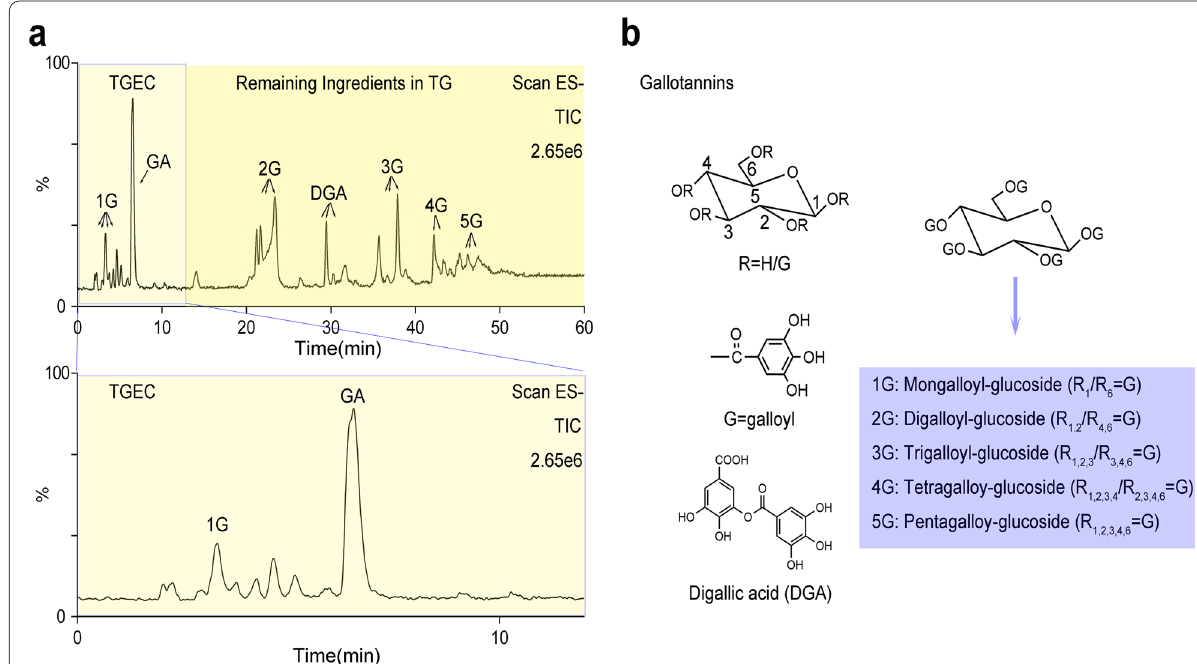
Fig. 2 Chemical composition of TGEC identification. a LC-MS spectrometry identify of Turkish Galls. b Fraction 15% ethanol of Turkish Galls was isolated by polyamide column chromatography and identified by